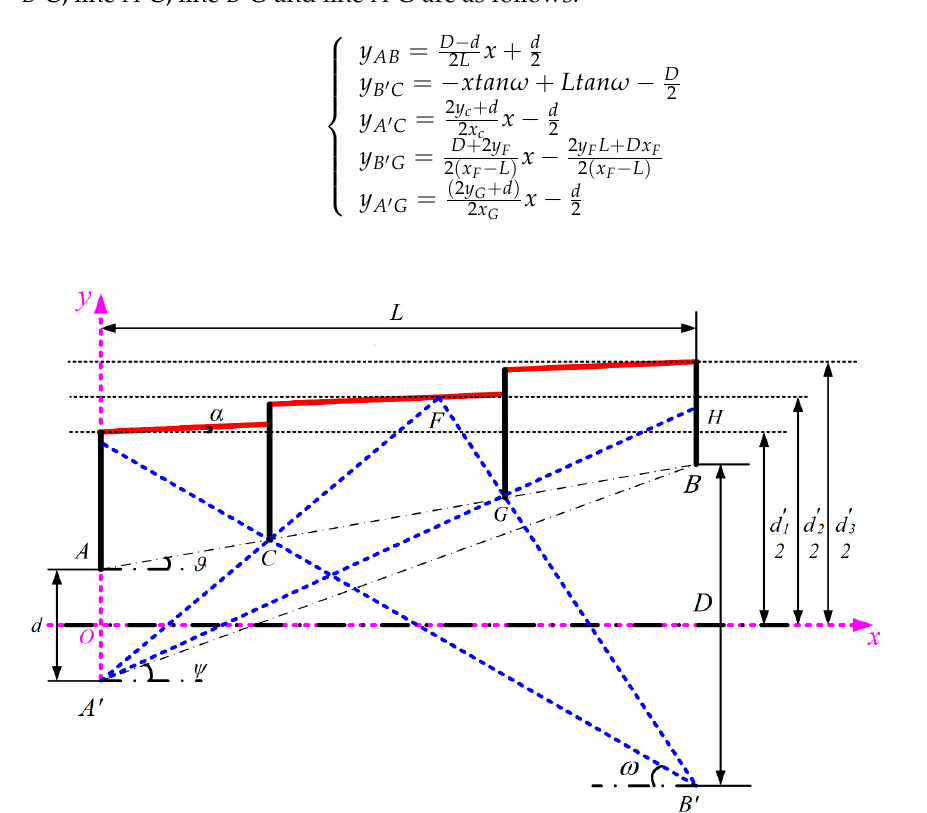
Figure 7. The deployable baffle design under the geometrograph method. Point 𝐻 must satisfy Equation (13) to cancel the third vane.